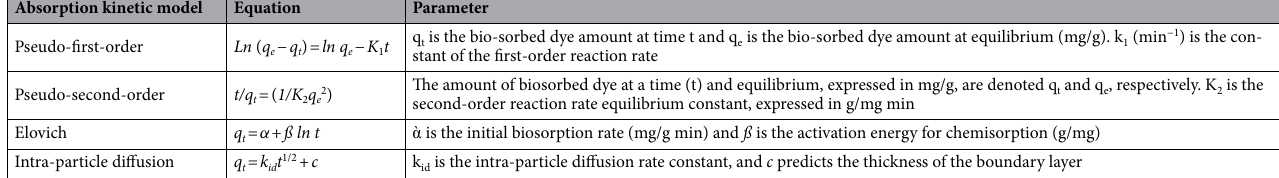
Table 3. Equations of kinetic models used to describe the biosorption of MB onto the dry biomass of the bio- sorbent